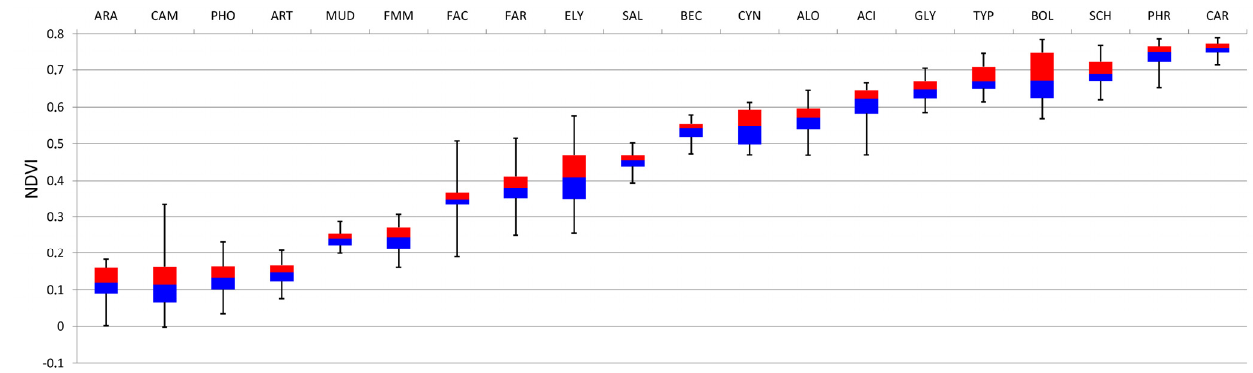
Figure 3. Boxplot of NDVI scores of random samples (50 pixels from each vegetation